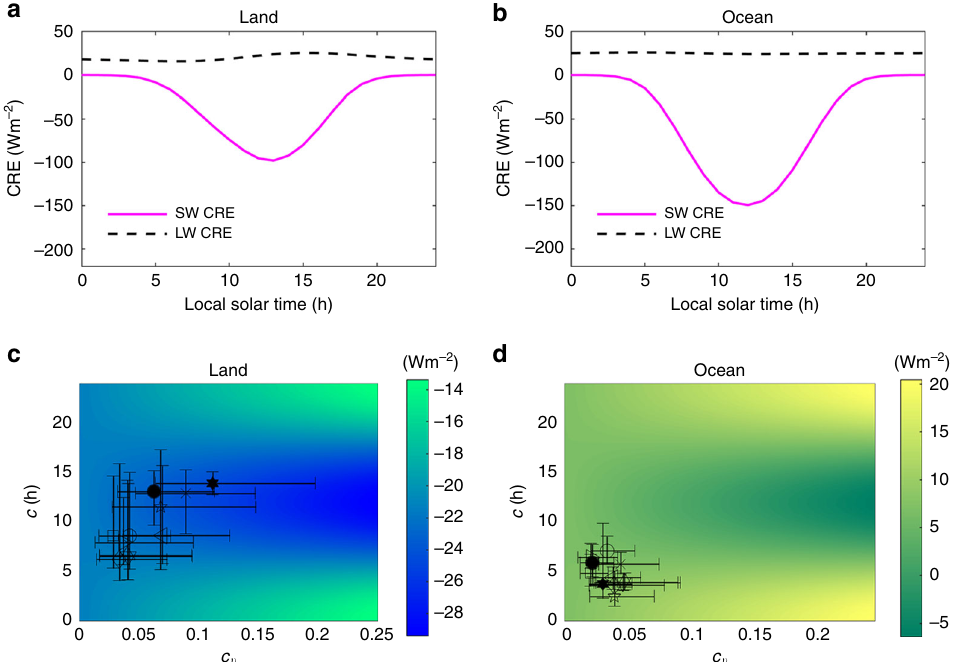
Fig. 3 Cloud radiative effects and reference irradiance at the top of the atmosphere. Global diurnal cycle of cloud radiative effects (CRE) climatology over the land ( a ) and ocean ( b ) from reanalysis outputs separated into shortwave and longwave components; heatmap of TOA reference irradiance as a function of coef fi cient of variation and centroid of cloud diurnal cycles over the land ( c ) and ocean ( d ). The crosses specify the 25th, 50th, and 75th percentiles of the c and c v from climate models (open markers, see details of the markers in Supplementary Table 1), satellite records ( fi lled hexagram), and reanalysis data ( fi lled